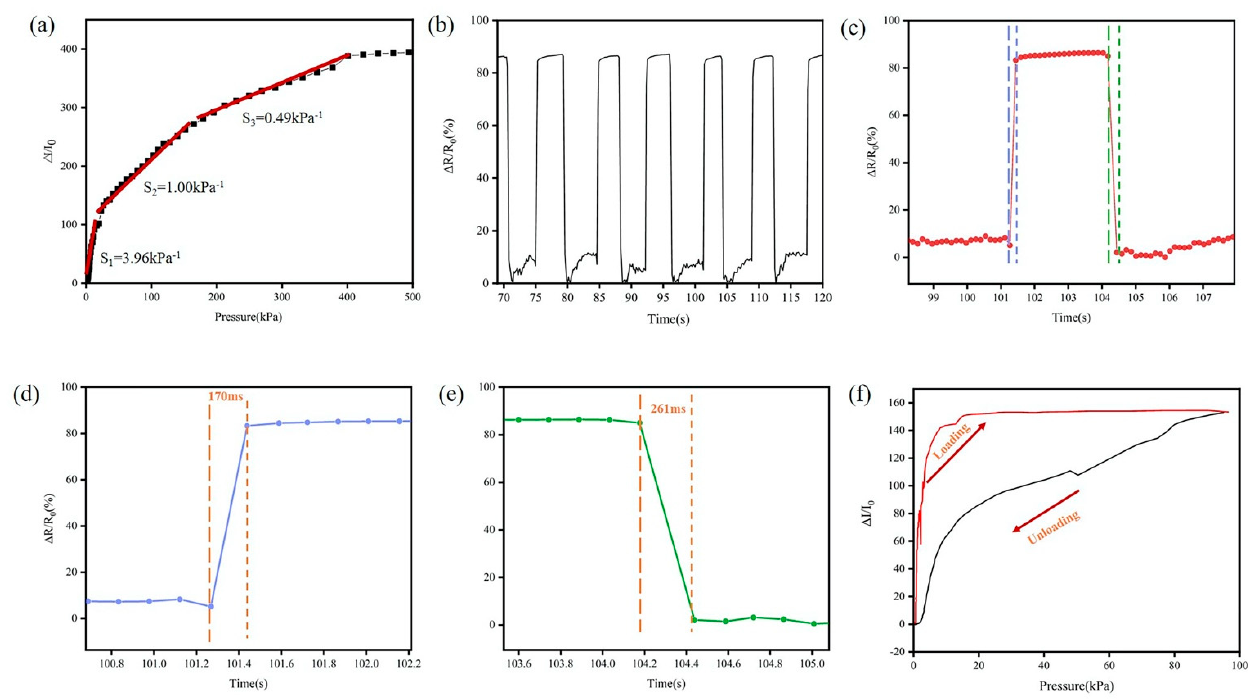
Figure 3. ( a ) The sensitivity performance of TPRS ( b ) real-time response of the sensor under an applied pressure of 5 kPa. ( c ) Pressure response showing a single cycle, and the corresponding ( d ) response time and ( e ) releasing time. ( f ) The hysteresis curves of TPRS.